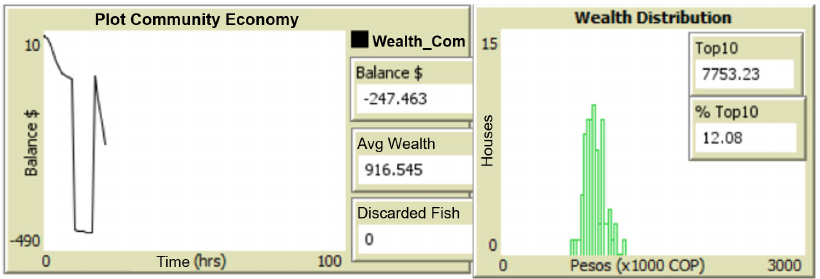
Figure 19. Interface of economic indicators implemented in Netlogo.